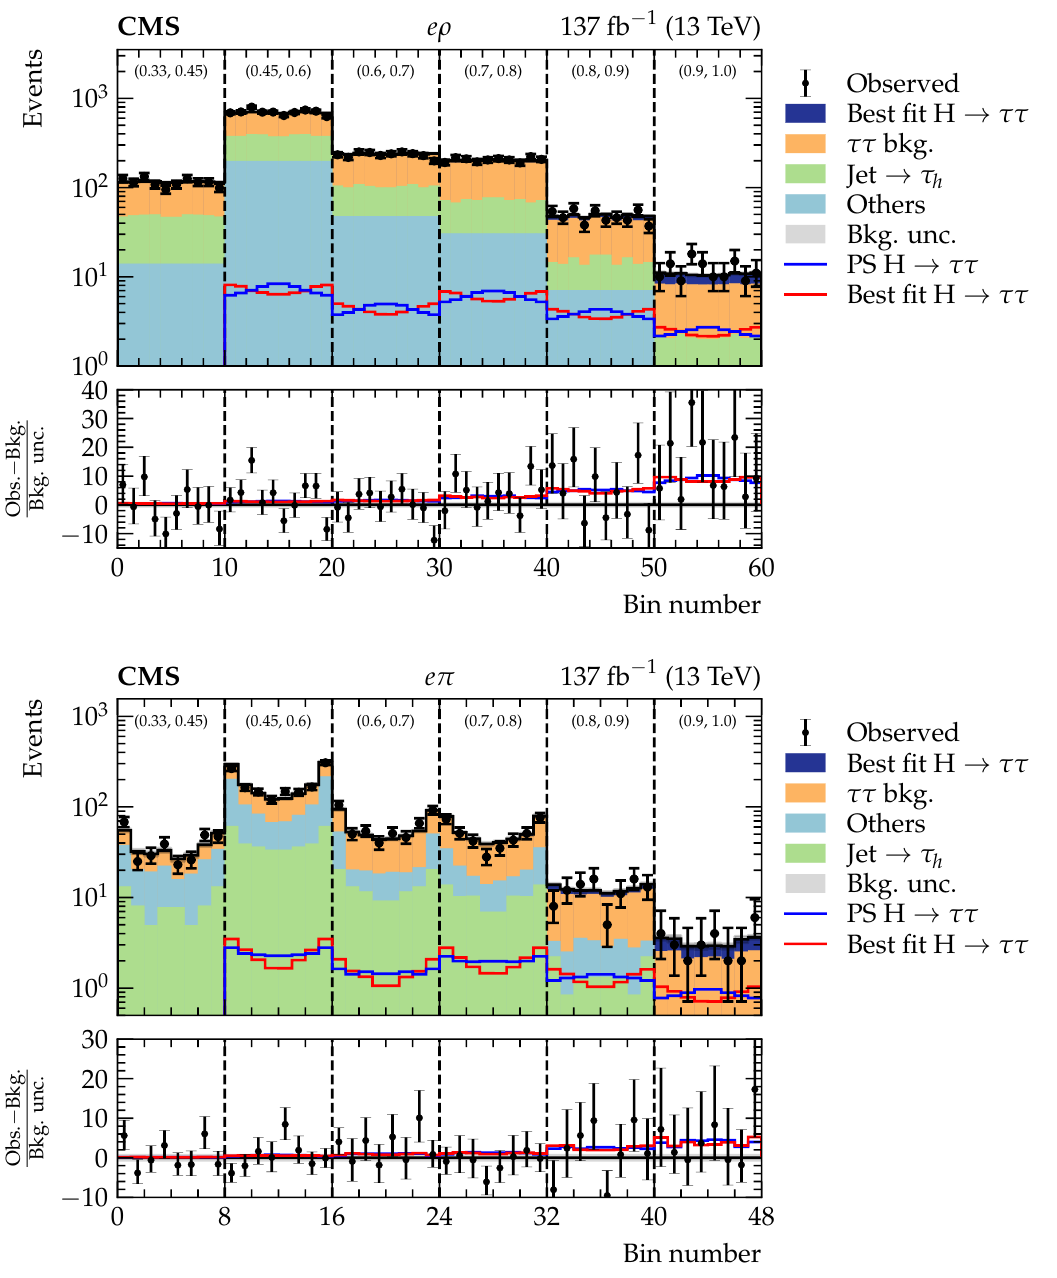
in the e r (upper) and e p (lower) channels in windows of increasing Figure 10 . Distributions of φ CP MVA score, shown on top of each window. The best fit and pseudoscalar (PS) signal distributions are overlaid, where in both cases the signal cross sections are set to the values obtained from the fit to data, which are given in section 12.1. The x -axis represents the cyclic bins in φ in the CP range of (0 , 360 ◦ ) . In the lower panels, the data minus the background template divided by the uncertainty in the background template is displayed, as well as the signal distributions divided by the uncertainty in the background template. The uncertainty band accounts for all sources of systematic uncertainty in the background prediction, after the fit to